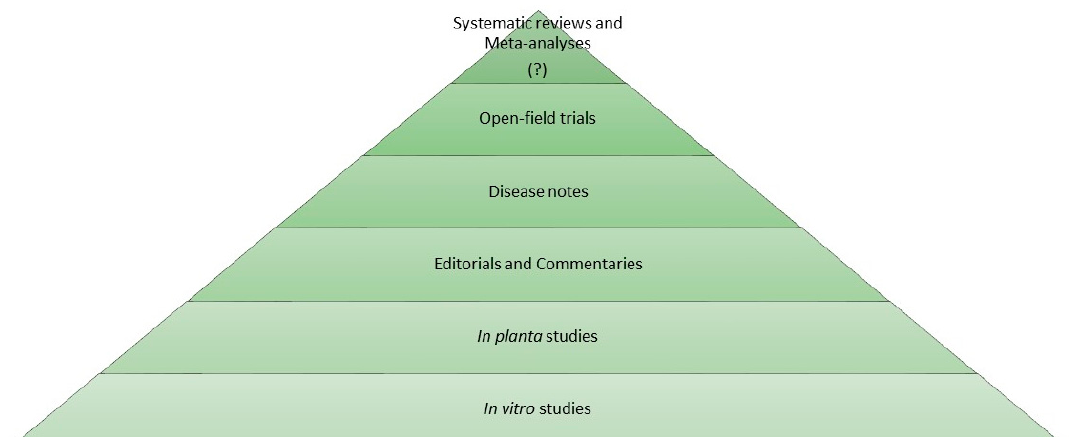
Figure 2. Pyramid of scientific evidence—Evidence-based phytoiatry (EBP). Suggested pyramid of the quality of scientific evidence in phytoiatry. In vitro and in planta experiments represent the level of the pre-open field research. Systematic reviews and meta-analyses need to be introduced in the phytoiatric/phytopathological area (‘?’ on the pyramid top).